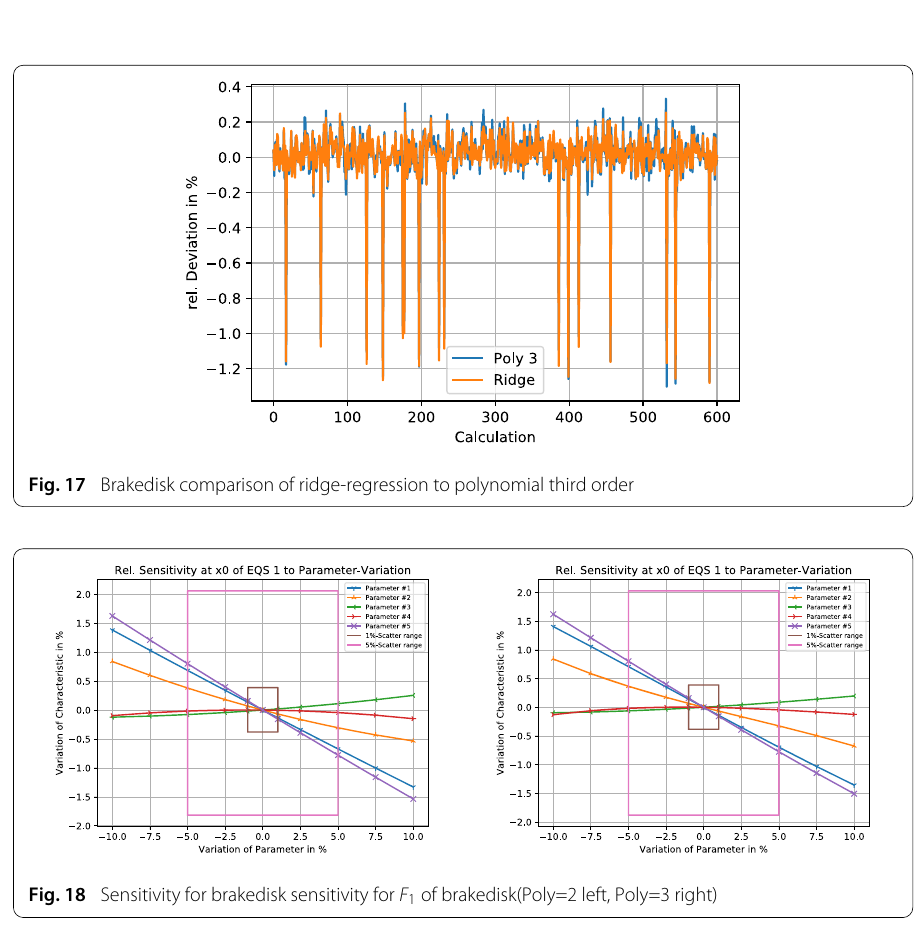
be kept in mind, that a sufficient number of input-data must be available to train the high order models. And a high order model does not necessarily result in improved